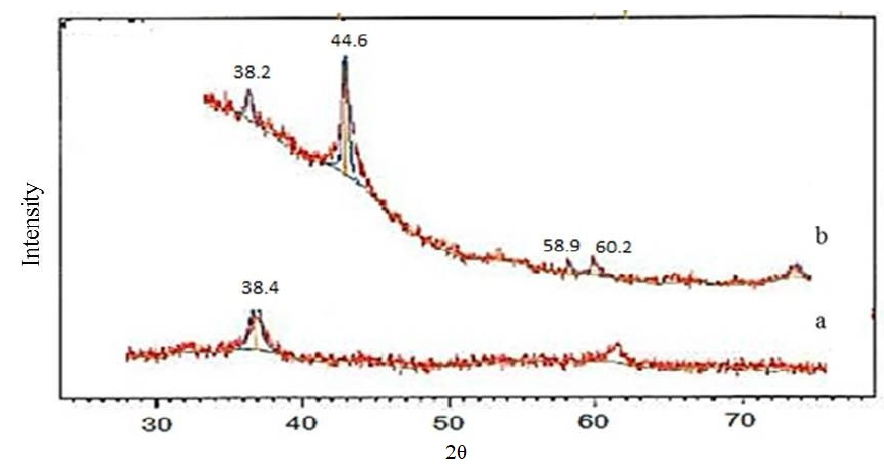
Figure 1. XRD patterns of ( a ) graphite and ( b ) magnetic graphene oxide.